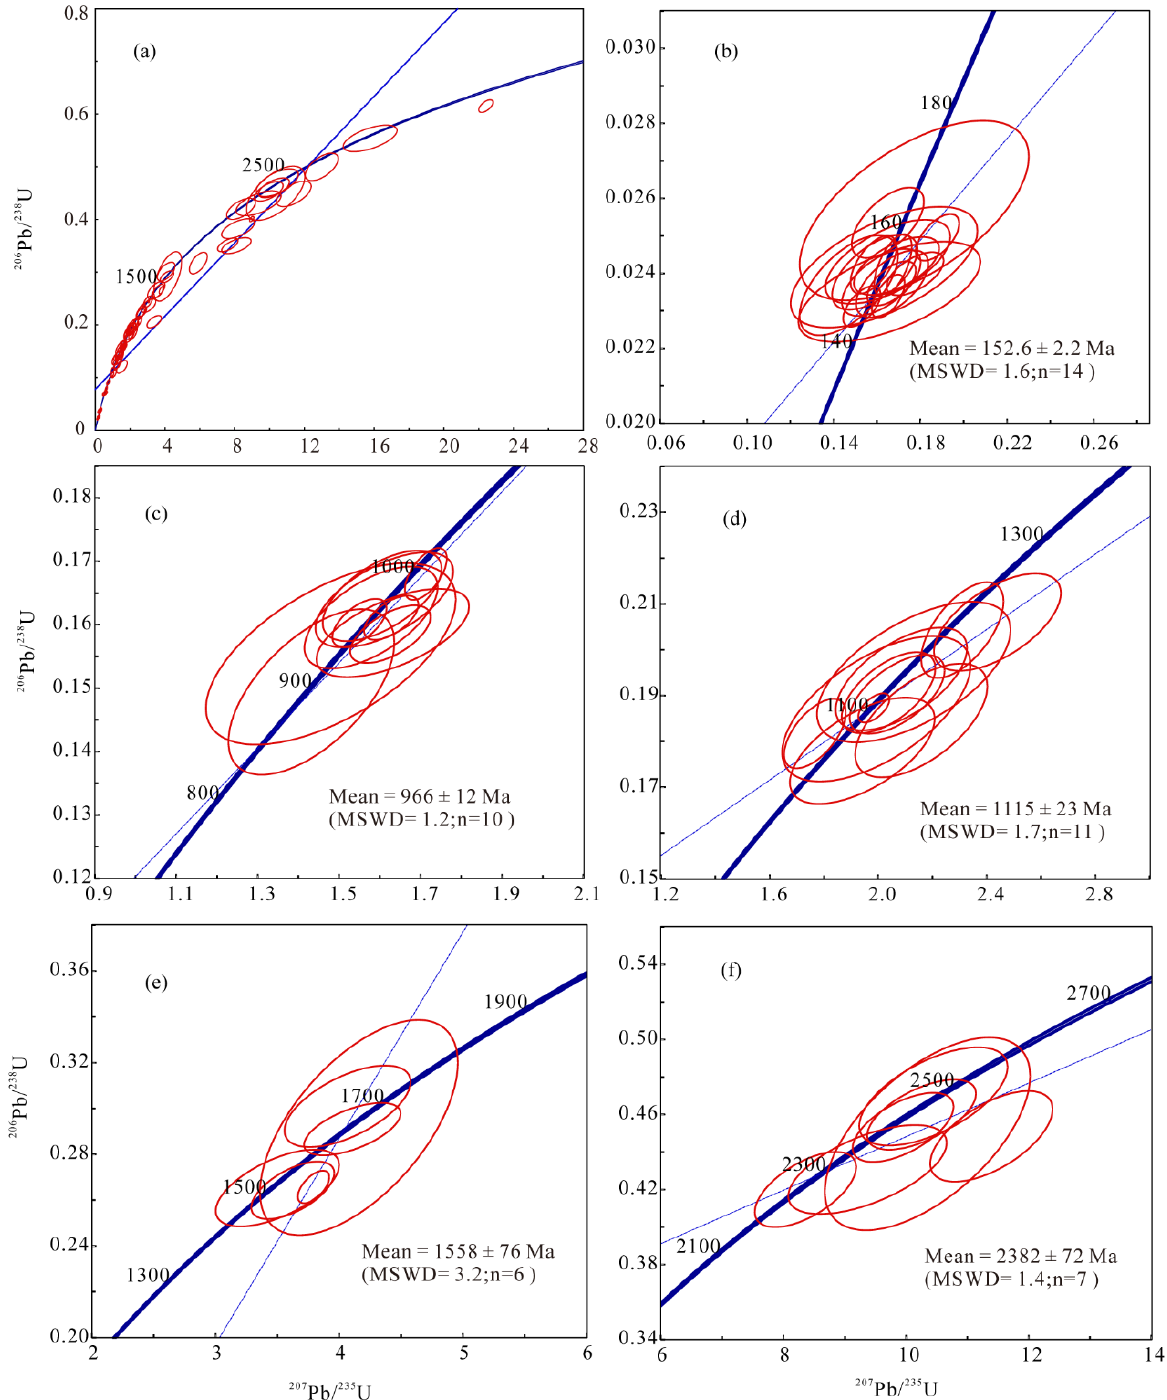
Figure 6. Concordia plots of zircon dating results for the Dengfuxian granites. ( a ) shows concordia plot of the whole data; ( b , c ) show concordia plot and mean average ages of Jurassic and Neoproterozoic, respectively. ( d , e ) show concordia plot and mean average ages of Mesoproterozoic zircons of ca. 1115 Ma and 1558 Ma, respectively; ( f ) show concordia plot and mean average age of Paleoproterozoic zircons. The red circle, bule solid lines and bule dashed lines represent the radius error for a single spot, concordant curve and unconcordant curve, respectively.